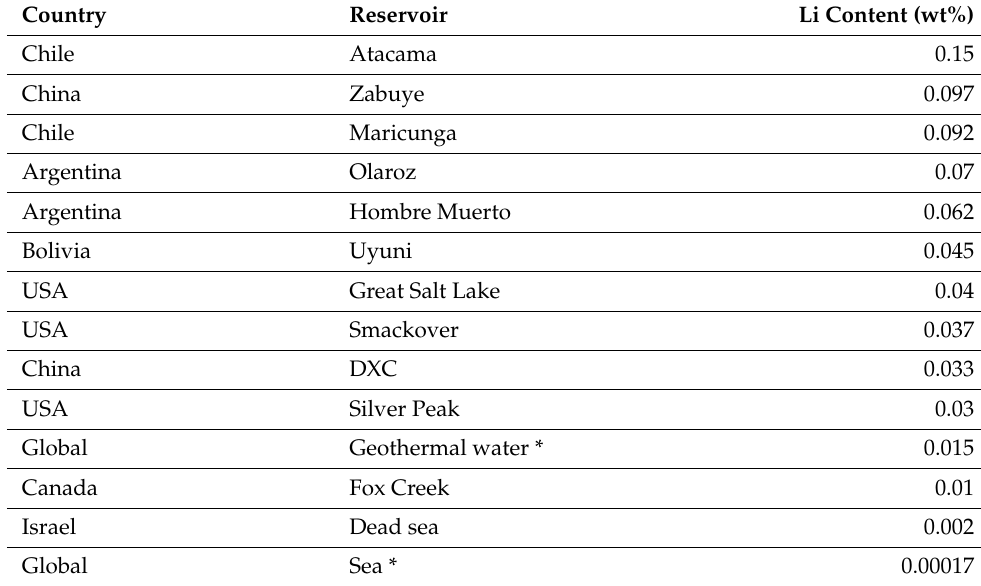
Table 2. The most common lithium salt pools